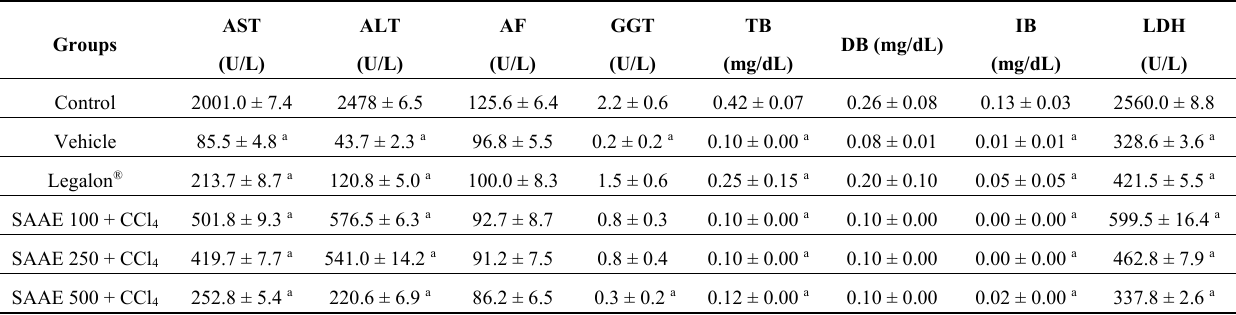
Table 2. Effects of the aqueous extract of Simarouba amara stem bark (SAAE) on biochemical parameters in Wistar